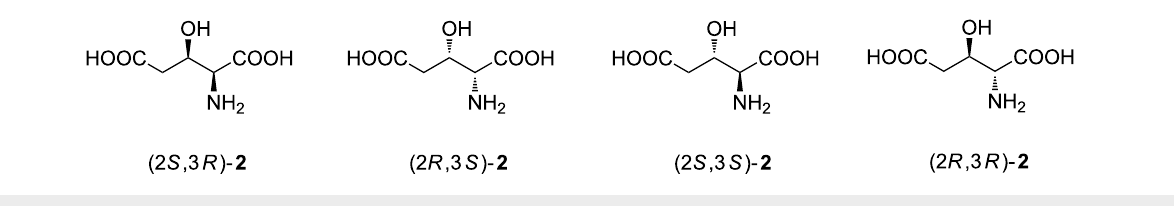
Figure 3: Enantiomers of 3-hydroxyglutamic acid ( 2